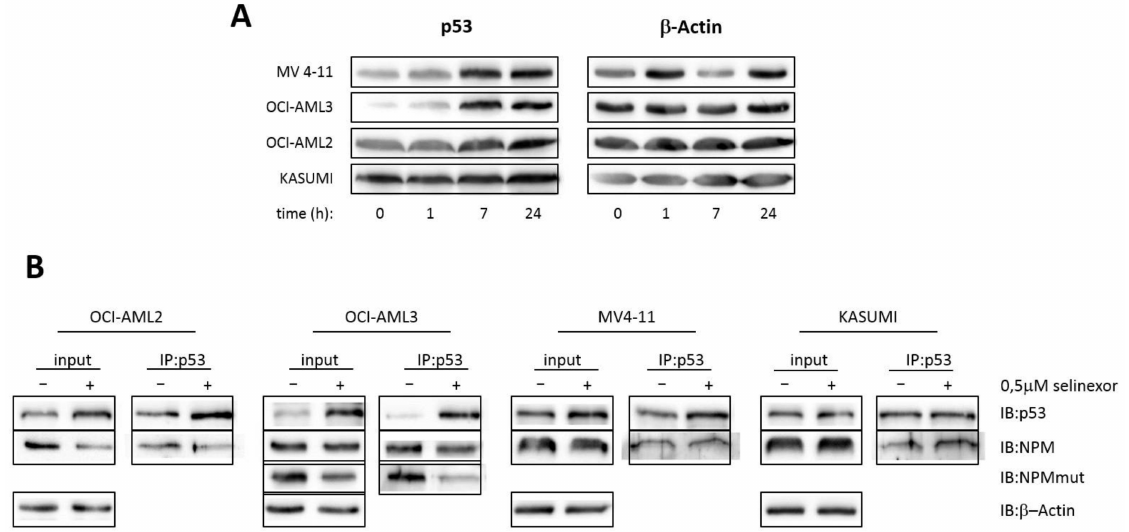
Figure 11. Effect of 0.5 µ M Selinexor on interaction between p53 and NPM in AML-derived cell lines. ( A ) p53 expression at indicated times after the Selinexor addition; ( B ) p53-precipitation 24 h after the Selinexor addition. Control samples without Selinexor were collected at the same time. Levels of co-precipitated NPM were investigated by immunoblotting. β -Actin expression served as a loading